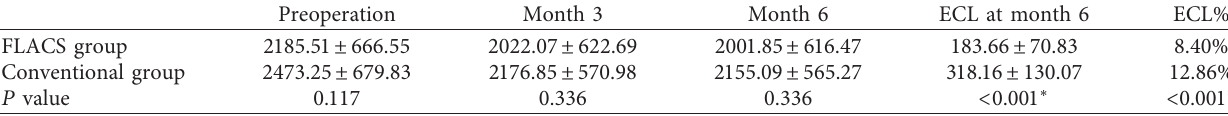
Table 3: Pre- and postoperative operative ECD between the two groups at different time points.